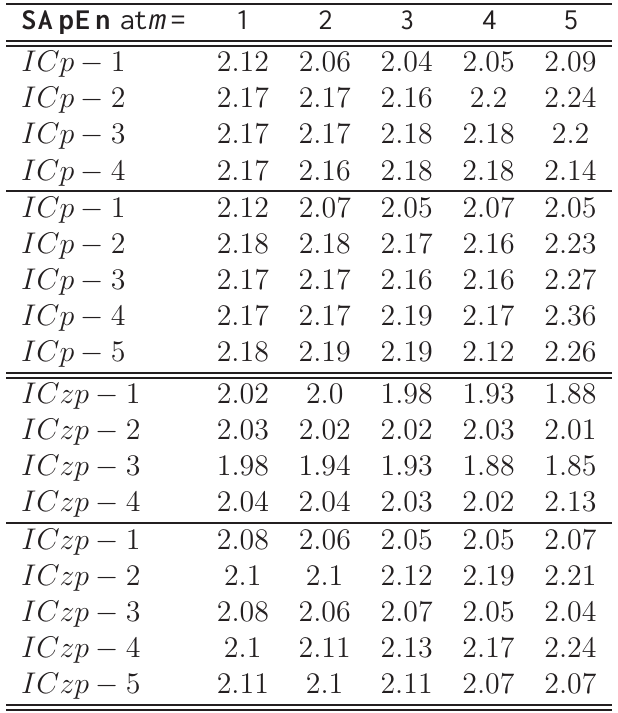
Table 8: Sample Approximate Entropy for each IC and ICz under perturbation and with epoch m = 1 , . . . , 5 . The symbol p indicates a perturbed system. scored versions differ in way that shows how the dispersion increases due to the presence of an extra component. As a further form of control, we have also computed the empirical